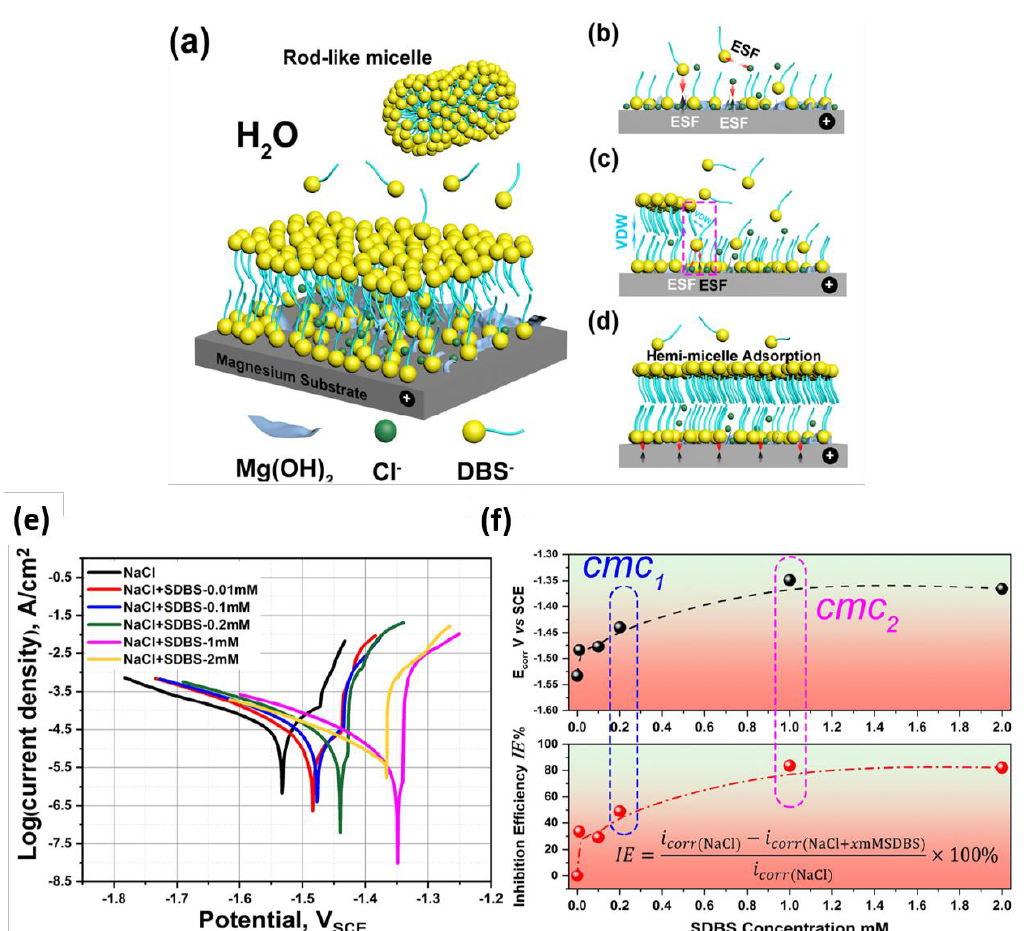
Figure 11. ( a – d ) Adsorption model of Mg surface in NaCl+SDBS solution with high SDBS concen- tration. ( a ) Bilayer structure formed by DBS − surfactant. ( b ) Negatively charged DBS − and Cl − adsorb on positively charged Mg substrate via electrostatic force (the black and white marked “ESF”, respectively, represent electrostatic repulsion and attraction). ( c ) Competitive adsorption between DBS − and Cl − (VDW illustrates “van der Waals” force) ( d ) Formation of hemi-micelle adsorption film. ( e , f ) Tafel potentiodynamic polarization measurements. ( e ) Tafel curves recorded in different solutions. ( f ) Corrosion potential and inhibition efficiency. The labeled cmc 1 and cmc 2 represent the concentrations of SDBS reaching spherical and rod-like micelles, respectively. Adapted from [128] with permission from Elsevier.